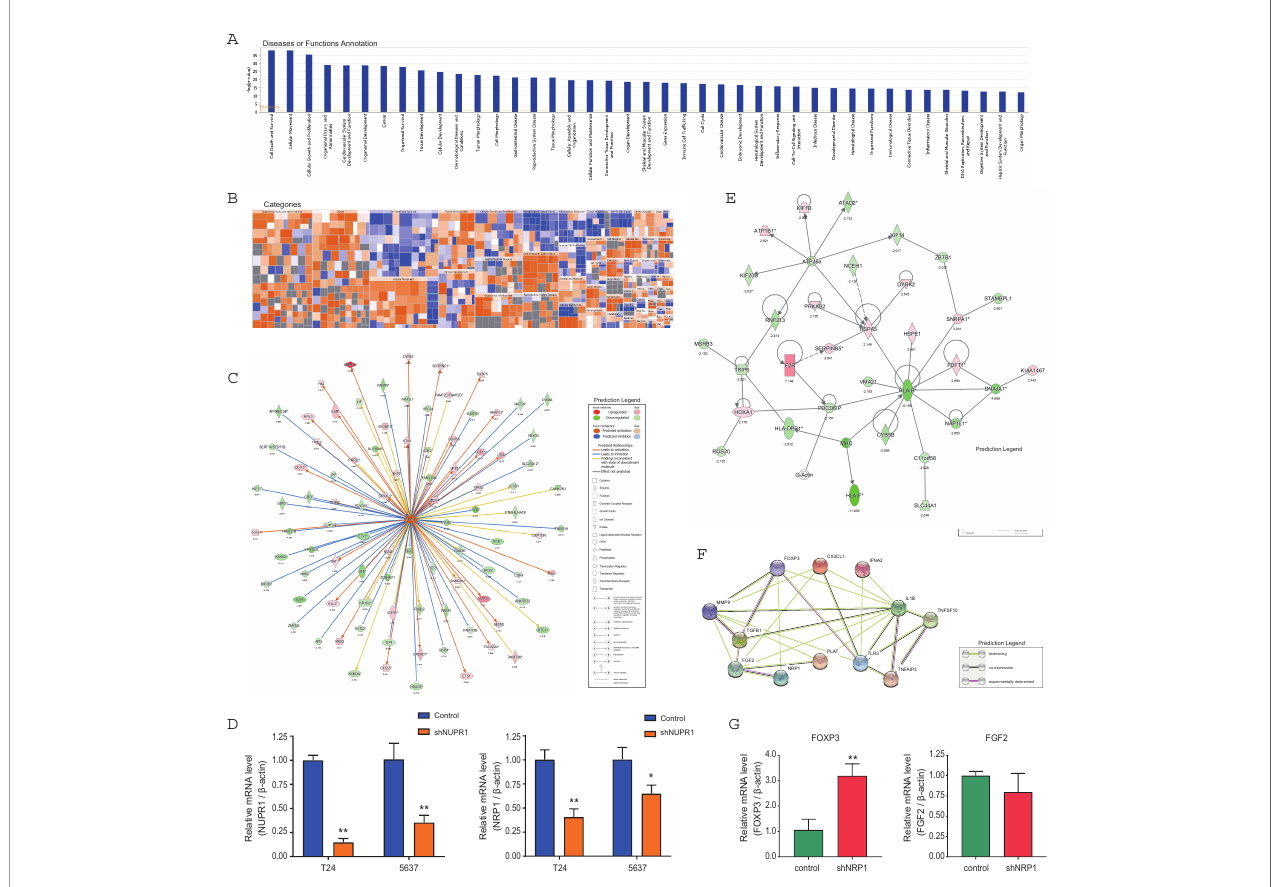
FIGURE 7 | Disease and functional, upstream and network analysis by IPA ® . (A) Disease and functional analysis using IPA ® evaluated the positive or negative correlation between NRP1 and other diseases or functions, which were ranked by log ( p -value). (B) The heatmap demonstrates the relationship between DEGs expression and activation or inhibition of diseases and functions categories. (C) Upstream analysis predicted that the NUPR1 regulatory network was activated after NRP1 was knocked down. (D) T24 and 5637 cells were infected with lentivirus-expressing NUPR1 or a control shRNA; the NUPR1 and NRP1 mRNA level was measured using qRT-PCR. (E) The molecular interaction network analysis predicted interaction among the molecules in the dataset and found that the top-ranked molecular interaction network was primarily enriched in the diseases and function categories of cancer, organismal injury and abnormalities and cell cycle, which including the altered genes after NRP1 silencing are shown. (F) The regulatory effect network analysis revealed that NRP1 may be a regulator in neovascularisation activation. (G) the mRNA expression of FOXP3 and FGF2 gene in 5637 cells with NRP1 silencing were measured using qRT-PCR. * p < 0.05 vs . the control group. ** p < 0.01 vs . the control